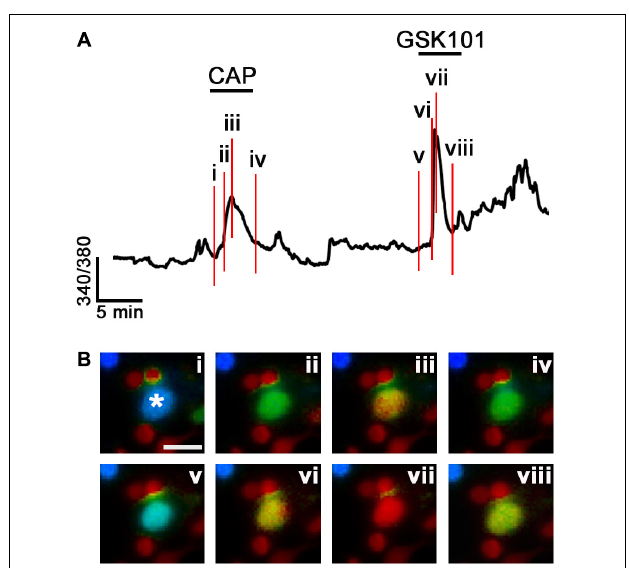
peak that inactivated in the continued presence of GSK101.